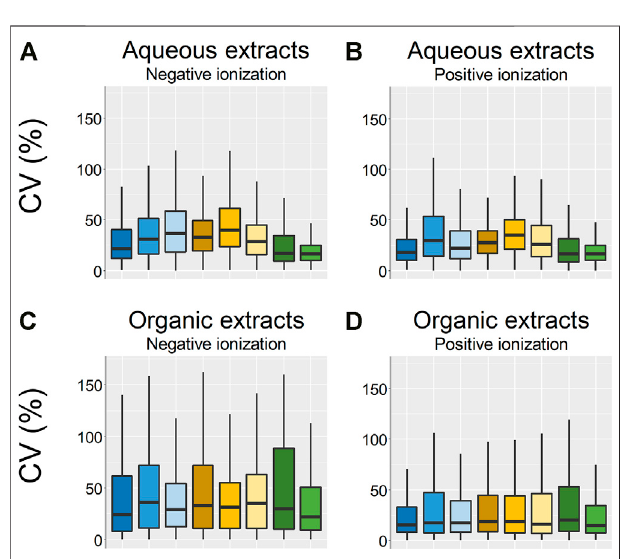
FIGURE 5 | Boxplotsover theCV:s (%)ofthe technicalreplicates ineach sample group. (A) Aqueous extracts,negative ionization, (B) aqueous extracts positiveionization, (C) organicextractsnegativeionization, (D) organicextracts positiveionization.EtOHextr.1(darkblue ),EtOHextr.2(blue ),EtOH sp. (light blue ), MeOH extr.1 (dark orange ), MeOH extr.2 (yellow ), MeOH sp. (light yellow ), frozen (dark green ), and fl ash frozen (green